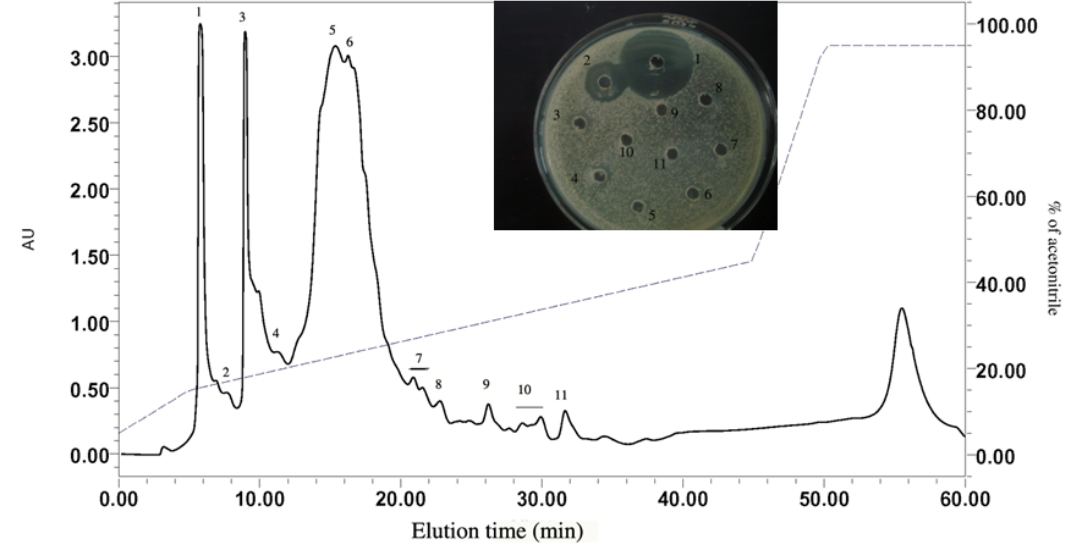
Figure 2. Fractionation and antibacterial activity of HAHp2-3 using preparative RP-HPLC. Numbers beside the wells were consistent with the peak numbers in RP-HPLC profile.